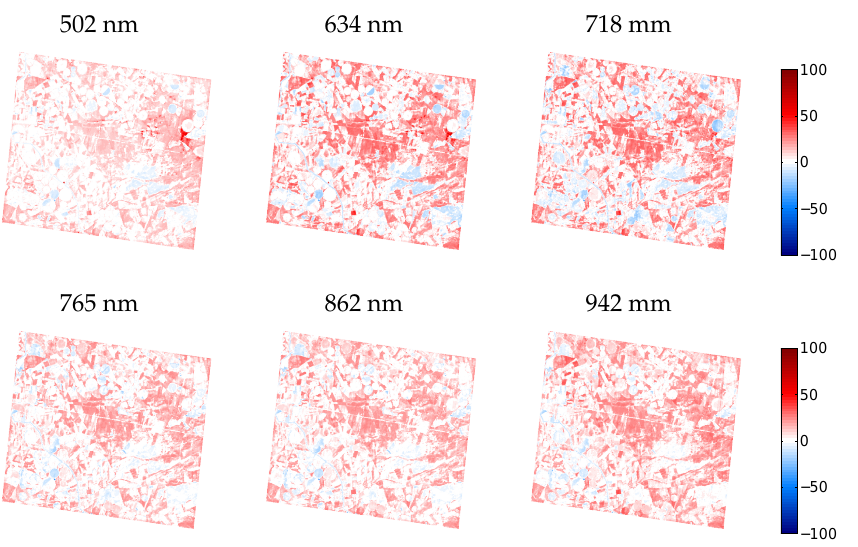
Figure 6. Relative difference maps (%) for arbitrarily chosen wavelengths between GPR-emulated scene and reference CHRIS